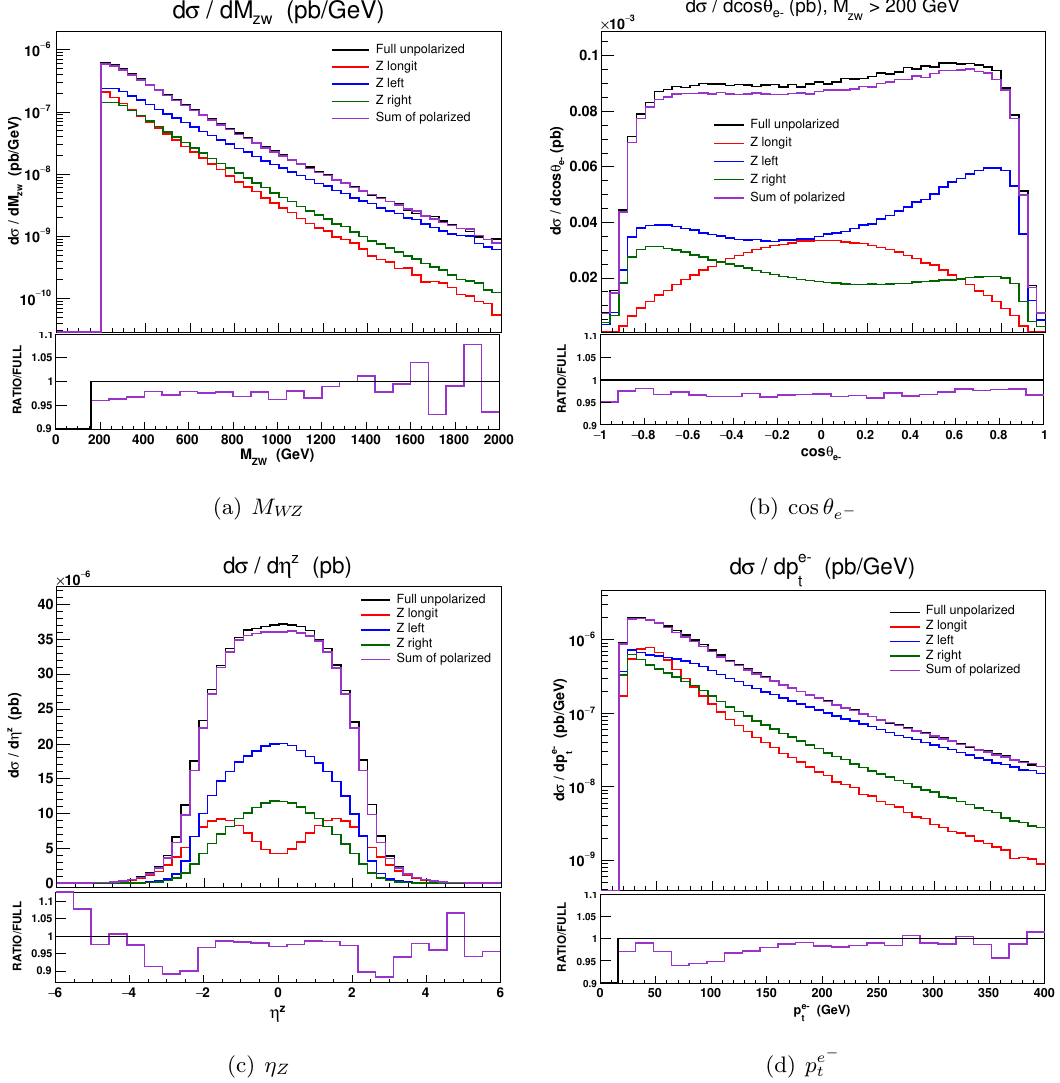
Figure 8 . W + Z scattering: di(cid:11)erential cross sections for a polarized Z boson, in the presence of lepton cuts and neutrino reconstruction. We show the full result (black), the single polarized distributions (red: longitudinal, blue: left handed, green: right handed) and the incoherent sum of the polarized results (violet). The pull plot shows the ratio of the sum of polarized distributions to the full